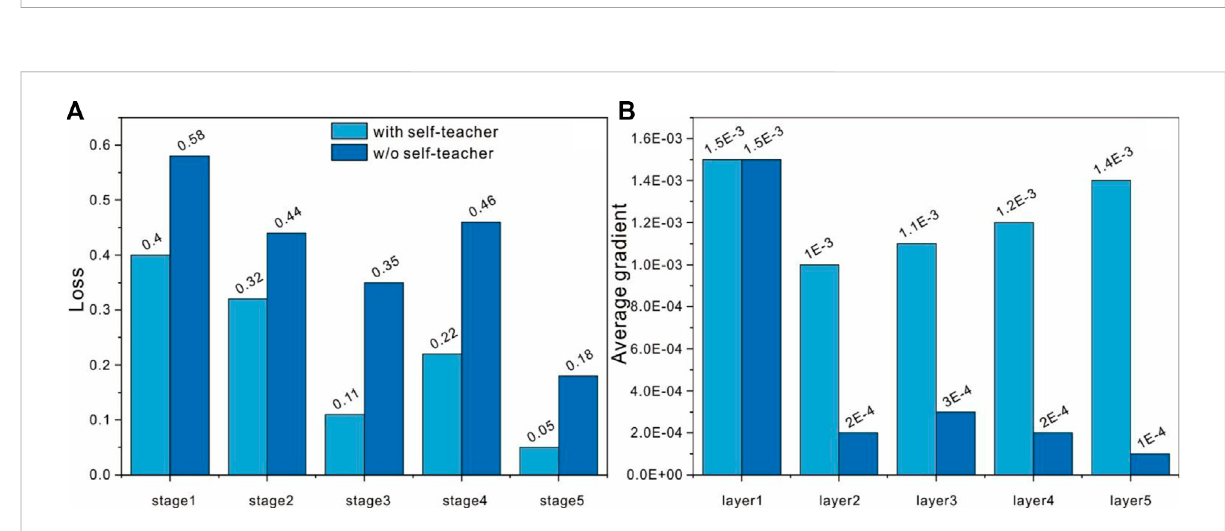
FIGURE 18 The variations of the average gradient among stages (A) collected dataset; (B) TGS